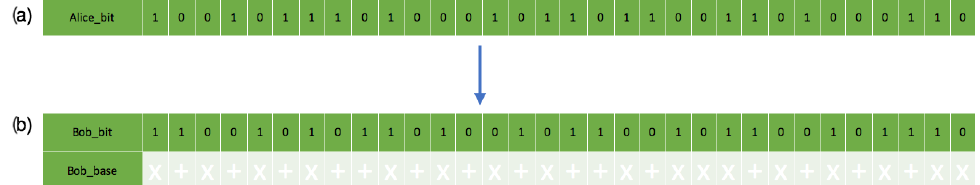
Figure 12. This is a figure showing the chosen bitstreams’ comparison: ( a ) Description of the sender’s chosen bitstreams. ( b ) Description of the receiver’s measurement and chosen bitstream with the associated polarization